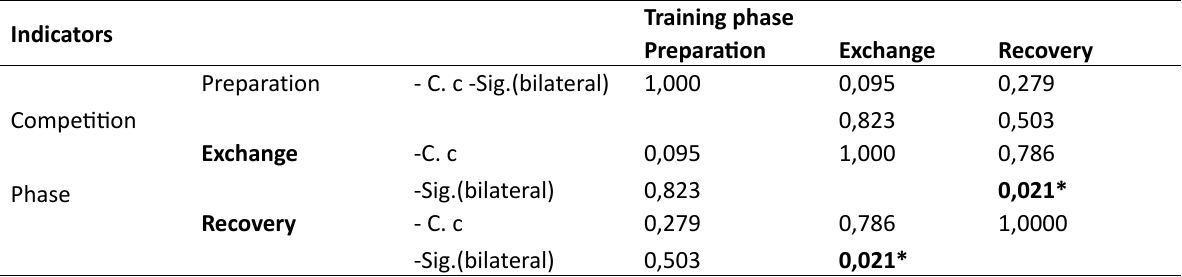
Table 9. Correlation between the preparation phase, exchange and recovery in training and competition.